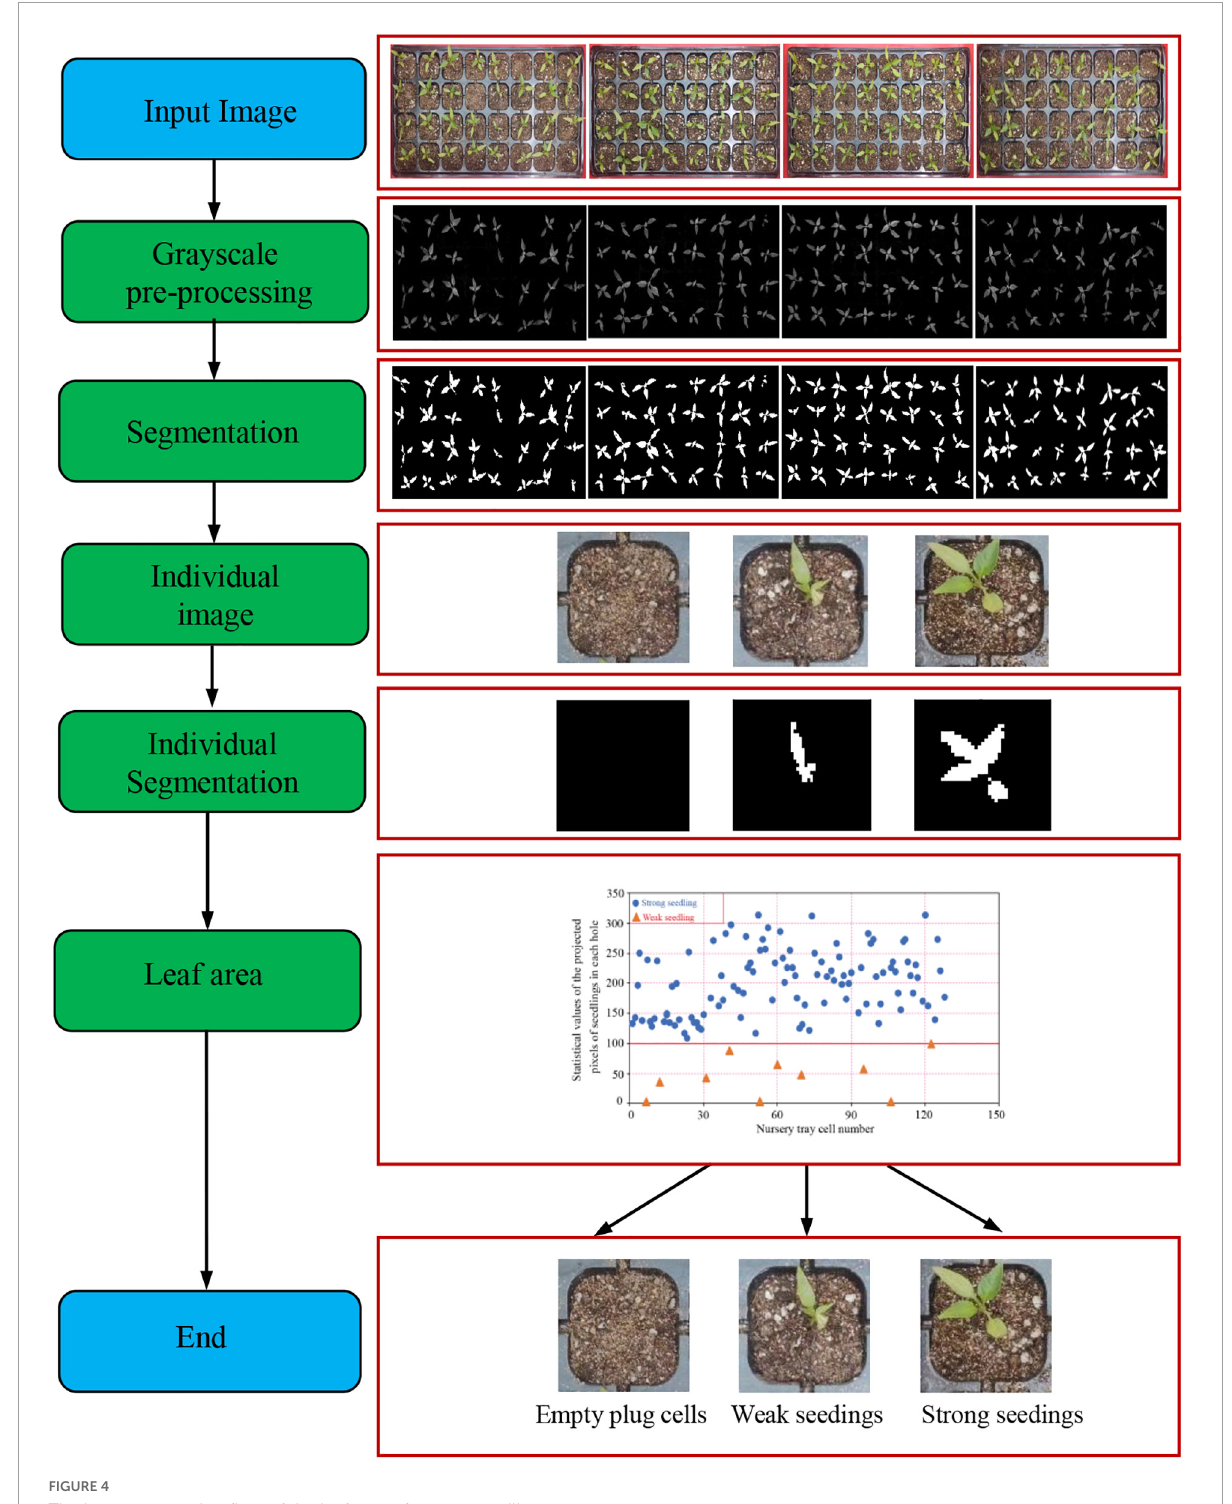
FIGURE4 The image processing flow of the leaf area of pepper